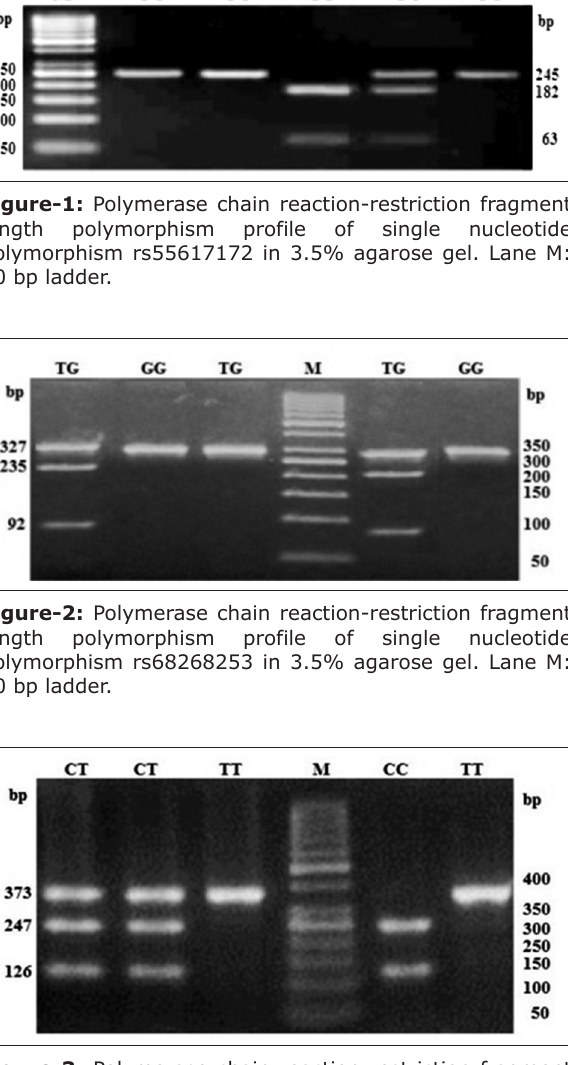
Figure-3: Polymerase chain reaction-restriction fragment length polymorphism